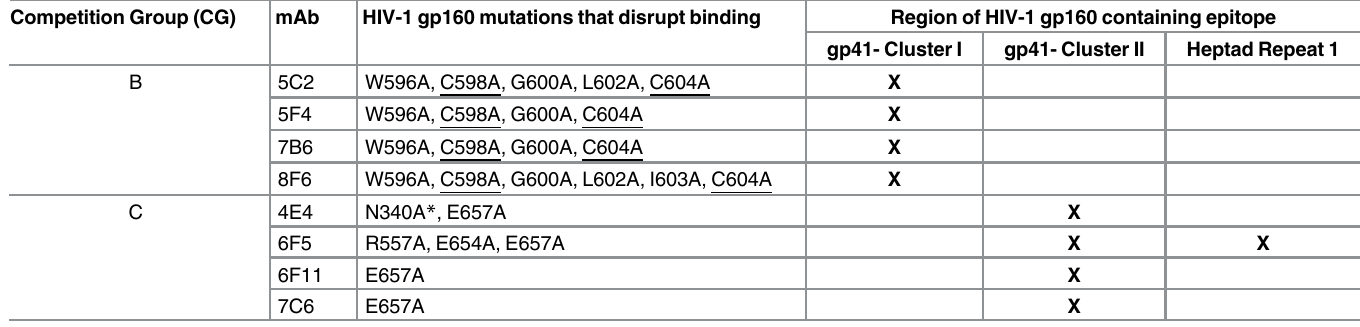
Underline indicates cysteines that are involved in disul fi de